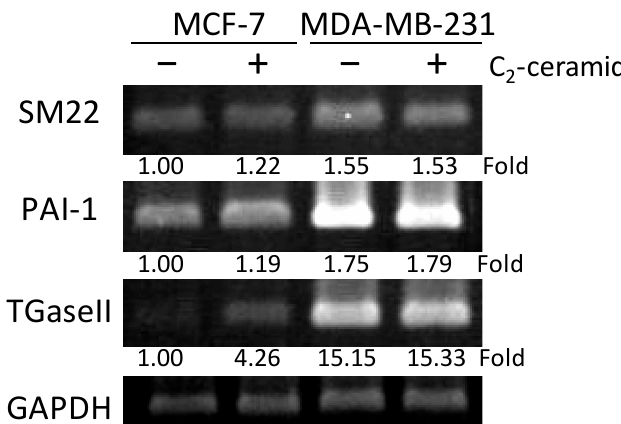
Figure 3. The detection of apoptosis in C 2 -ceramide-treated breast cancer cells. MDA-MB-231 cells were treated with the indicated concentrations of C 2 -ceramide (from 5 to 50 μ M) for 24 h respectively. ( A ) The cells were observed using phase-contrast microscopy. ( B ) Chromatin condensation is shown, a hallmark of apoptosis induced by ceramide treatment. The white arrows indicate the chromatin condensation-positive cells. ( C ) The fluorescence microscope-based apoptosis assessment using annexin-V conjugated FITC and Propodium Iodide dual staining. ( █ Annexin-V-positive, █ propidium iodide and █ indicates the late stage of apoptotic cells). ( D ) The protein changes of pro-apoptotic Bad and cleavage of caspase-3 indicate an index of proteolytic activation. Nought indicates the cells were treated with C 2 -ceramide-free solvent as a vehicle control. β -actin as an internal control. Scale bar: 100 μ M * p < 0.05, ** p < 0.01.